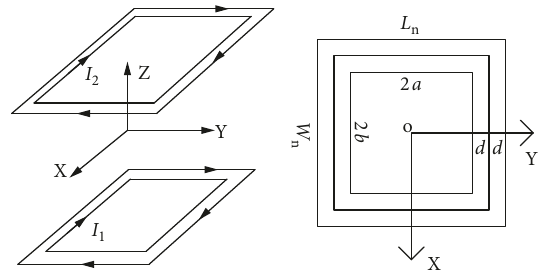
Figure 6: Coordinate diagram of coaxial multi-turn transmitting coil and receiving